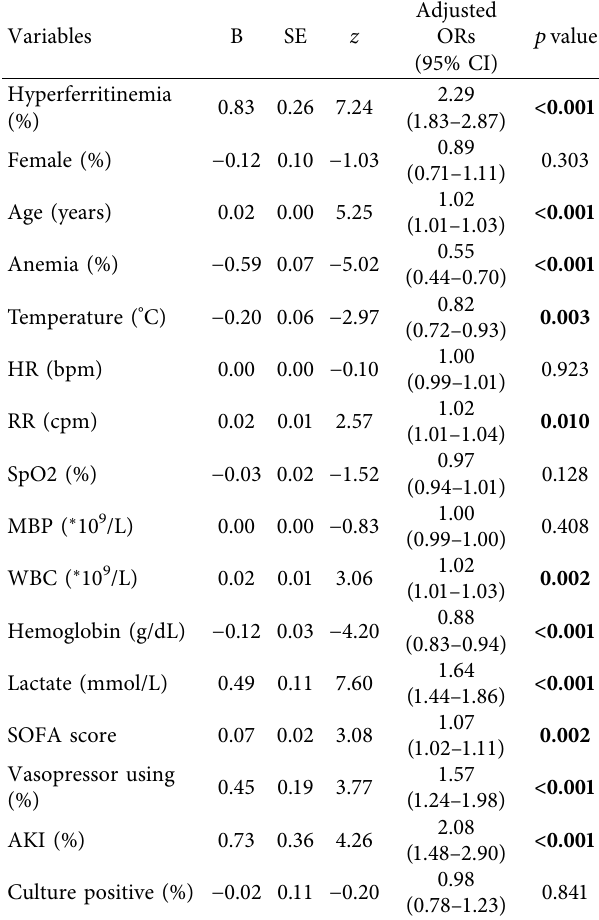
Table 3: Results of log-binomial model